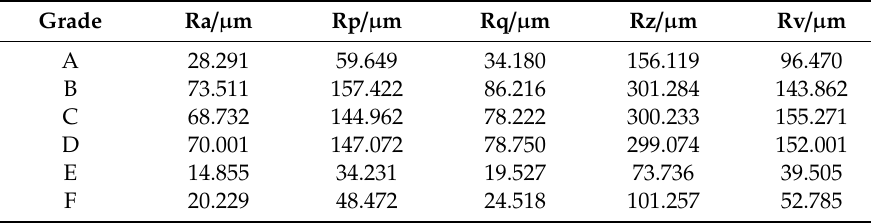
Table 6. Average surface texture parameters of aggregates.